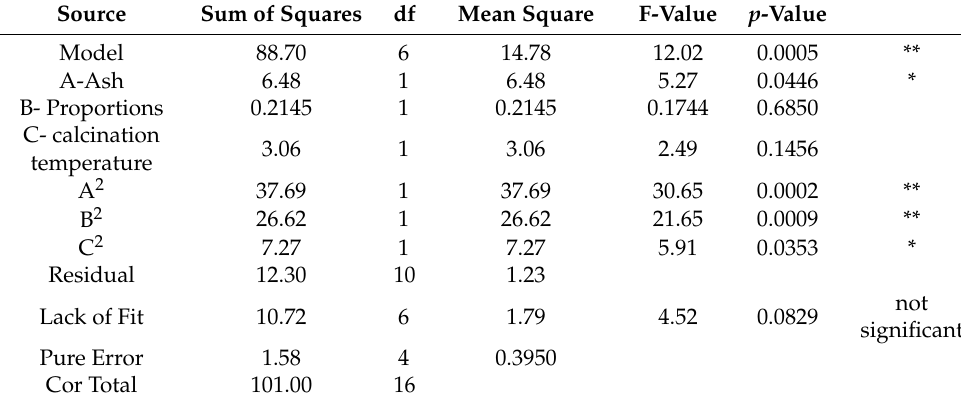
Table 6. Analysis of variance for the optimized regression model.